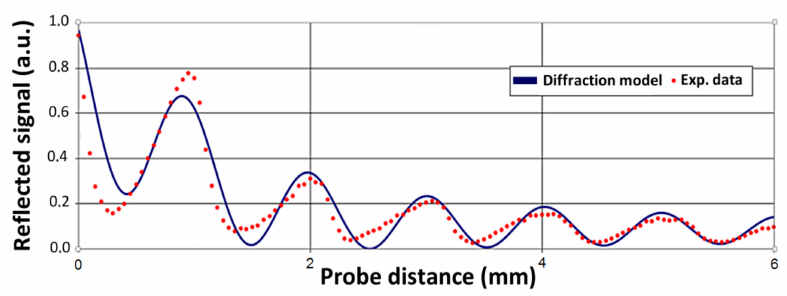
Figure 4. Behavior of the reflected signal as a function of the distance from the sample. Experimental points (dots) are compared with the theoretical model (solid line).